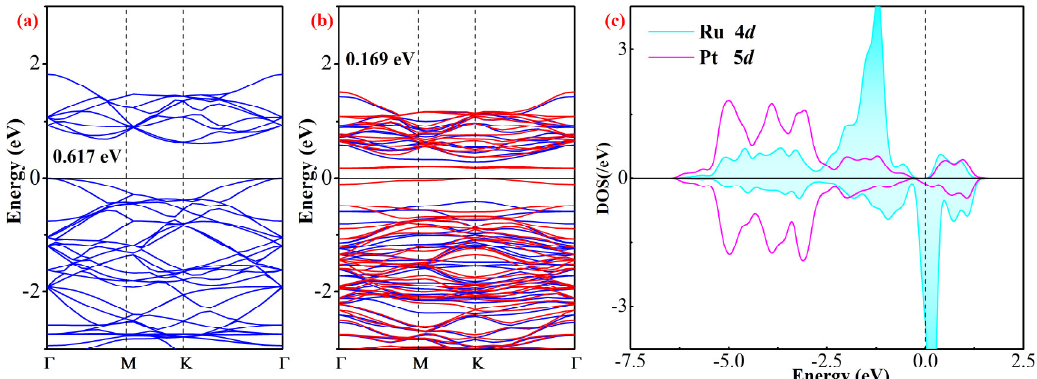
Figure 3. ( a , b ) BS of pristine and Ru-doped PtTe 2 systems; ( c ) orbital DOS of Ru and Pt atoms. In the BS, the black values are bandgaps, the black lines are spin-up, and the red lines are spin-down; in the DOS, the dash line is the Fermi level.